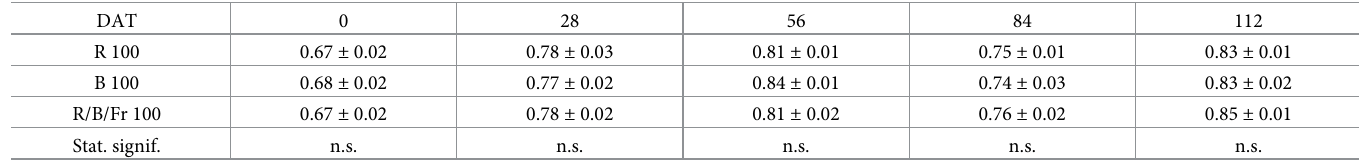
Table 9. Normalized difference vegetation index (adim.) at various days after treatment (DAT) in Taxus baccata exposed to different light quality (R, red; B, blue; Fr, far red) at 100 μ M m-2 s-1. Data are means ± SE (n = 6). DAT